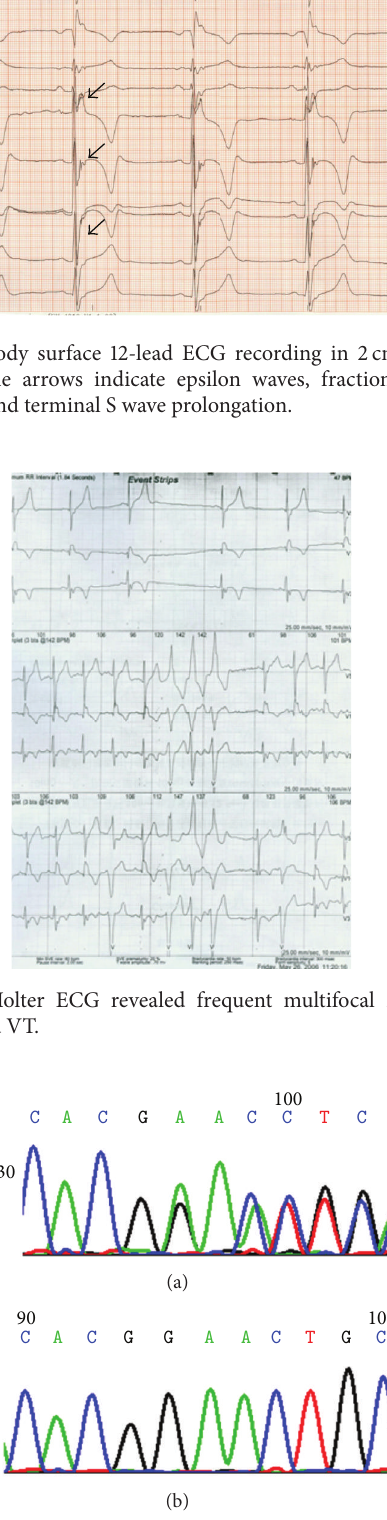
Figure 5: PKP2 mutation (above) versus wide type